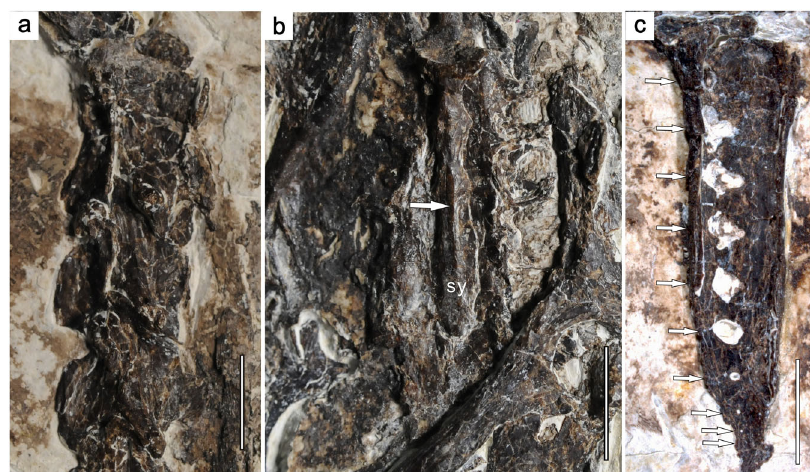
Fig. 4 Selected axial elements of Confuciusornis shifan holotype (PMoL-AB00178). a cervical vertebrae. b synsacrum. c pygostyle. sy synsacrum. Arrows in b and c indicate the longitudinal ridge on the ventral surface of the synsacrum and the positions of foramina along the pygostyle, respectively. Also see Supplementary Fig. 1 for a close-up of the distal part of the pygostyle. Scale bars: 0.5 cm in a , c ; 1 cm in b